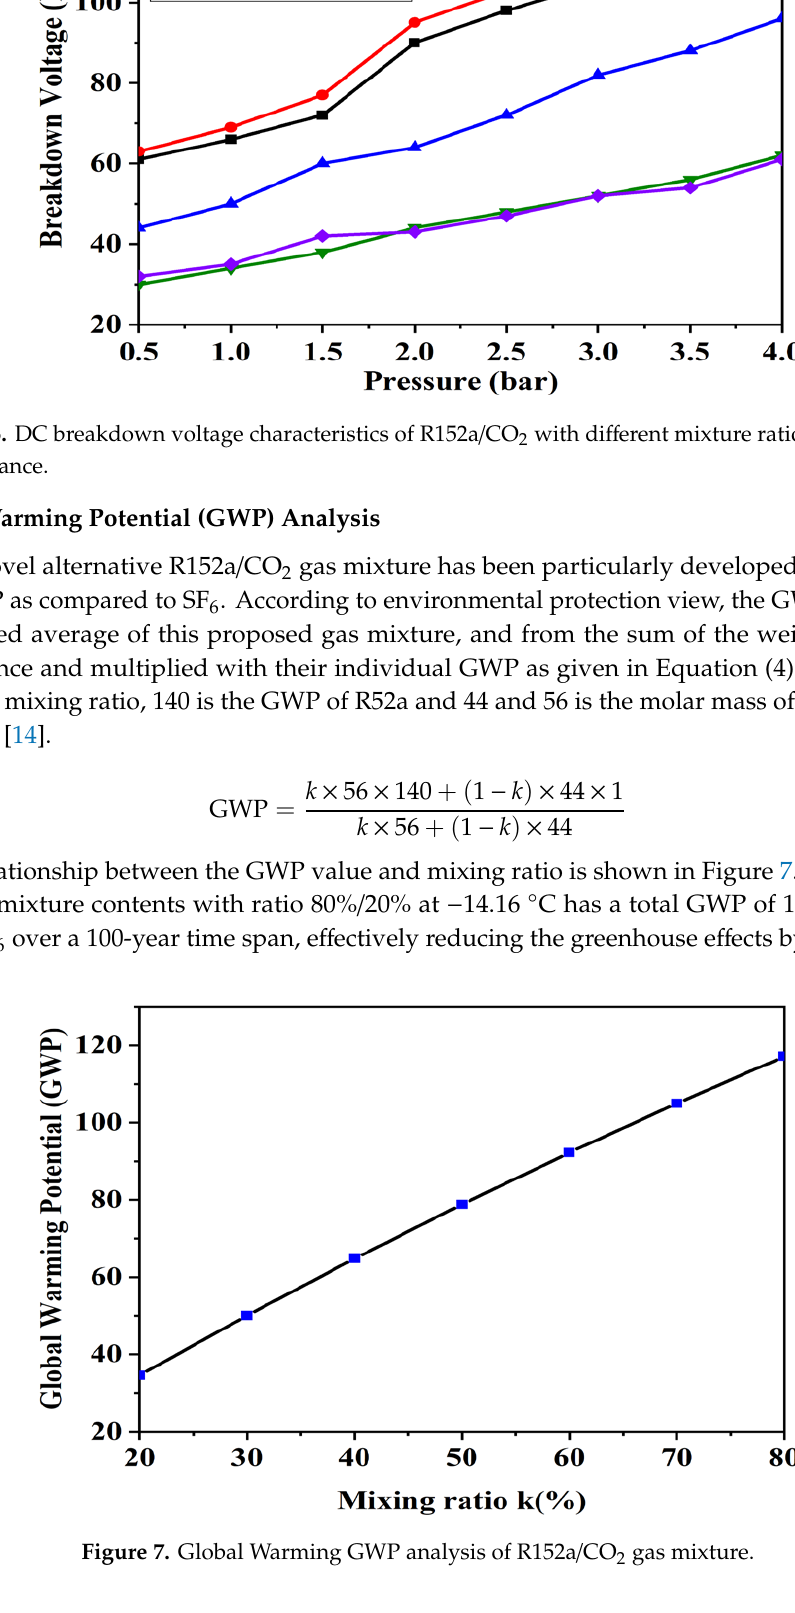
Figure 8. Saturated vapor pressure R152a and SF 6.